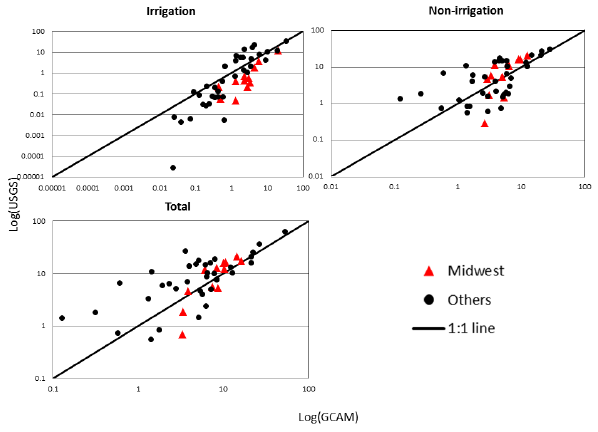
1 Fig. 3. Comparison of GCAM water withdrawal values in year 2005 Figure 3: Comparison of GCAM water withdrawal values in year 2005 to USGS values (log-log scale) by states of the 2 United States, and for the Midwestern states. 3 to USGS values (log-log scale) by states of the United States, and for the Midwestern states.